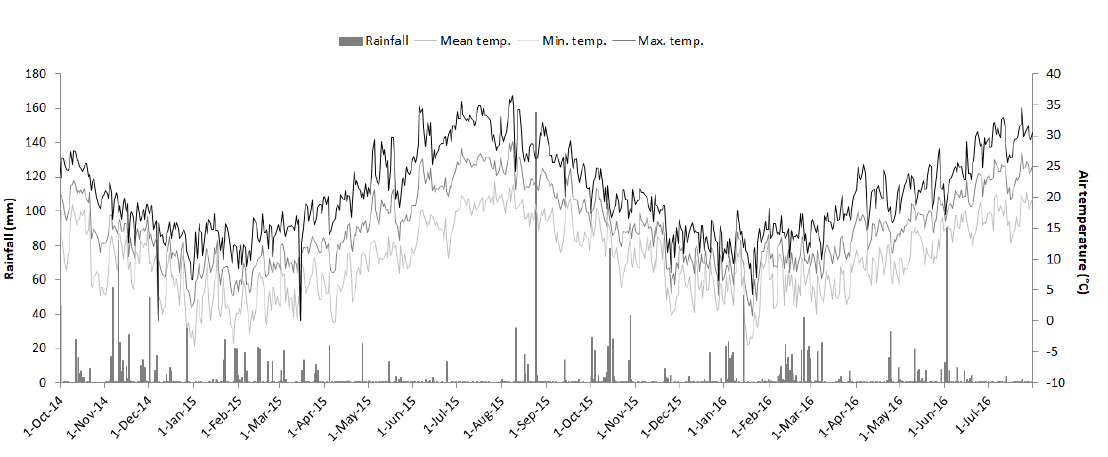
Figure 2. Daily rainfall (mm), daily maximum, average and minimum air temperature (°C) from October 2014 to July 2016.